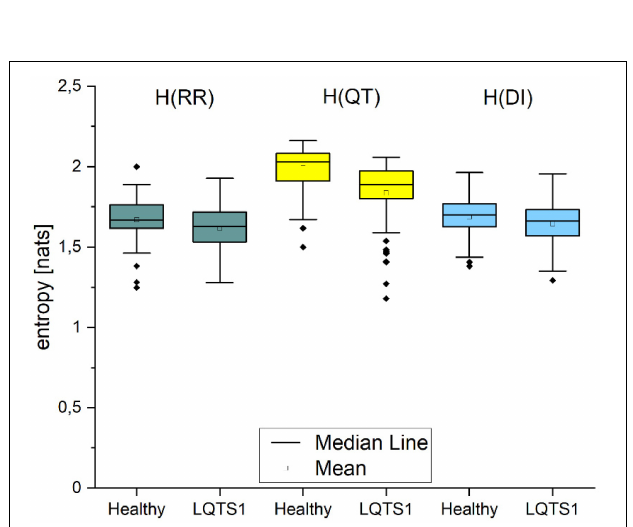
FIGURE 2 | Shannon entropy H of the individual processes given by single time series: RR intervals, QT intervals, and diastolic intervals, respectively. The Kolmogorov–Smirnov test was used, p -values: H(RR): 0.04348, H(QT): 1.41241E-7, H(DI): 0.0998.